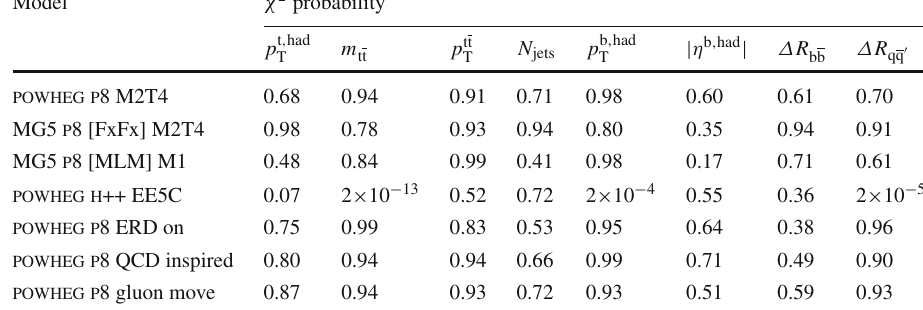
Fig. 3 Measurements of m t as a function of the invariant mass of the tt system m tt (upper left), the number of jets N jets (upper right), the pseudorapidity of the b jet assigned to the hadronic decay branch | η b , had | (lower left) and the Δ R between the light-quark jets Δ R qq (cid:4) (lower right) compared to different generator models The filled circles represent the data, and the other symbols are for the simulations. For reasons of clarity, the horizontal bars indicating the bin widths are shown only for the data points and each of the simulations is shown as a single offset point with a vertical error bar representing its statistical uncertainty. The statistical uncertainty of the data is displayed by the inner error bars. For the outer error bars, the systematic uncertainties are added in